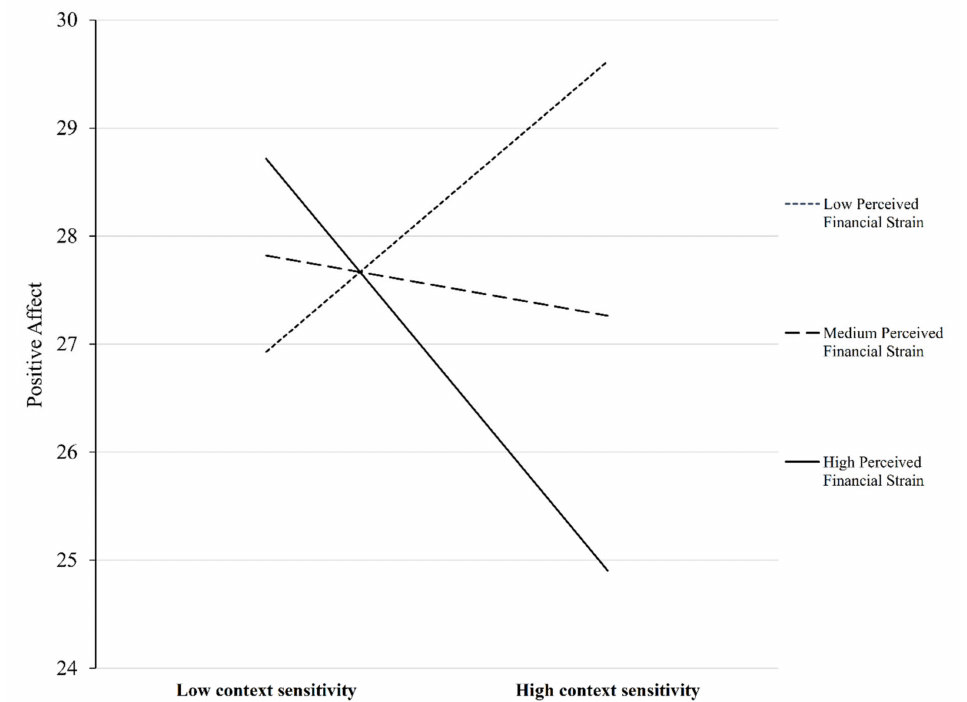
Figure 2. Plot of the moderating effect of perceived financial strain on the association between context sensitivity in routines and positive